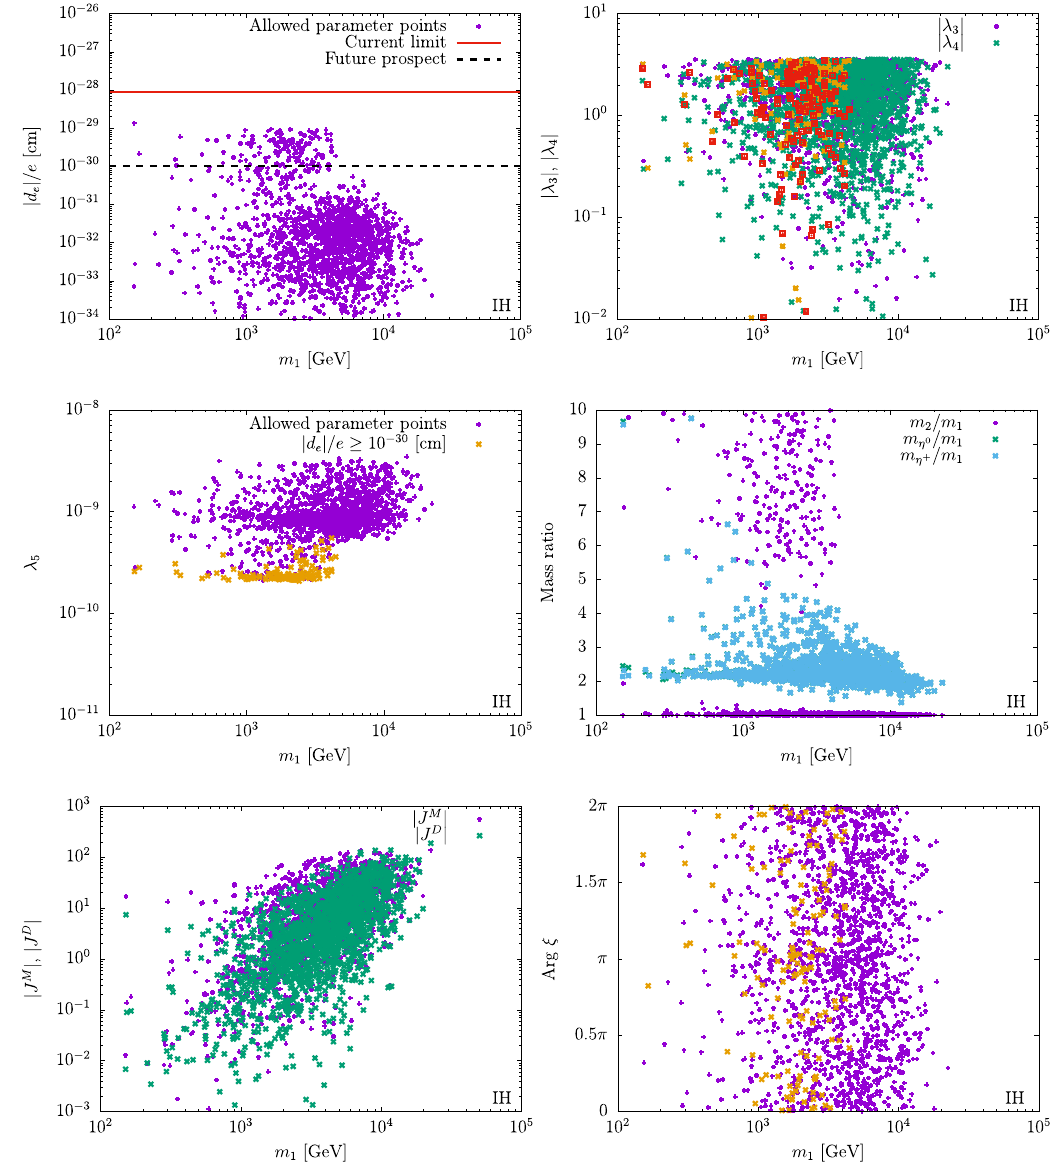
Figure 5 . Numerical results for fermion dark matter in the case of inverted hierarchy for the light neutrino spectrum. Each point complies with all the constraints discussed in section